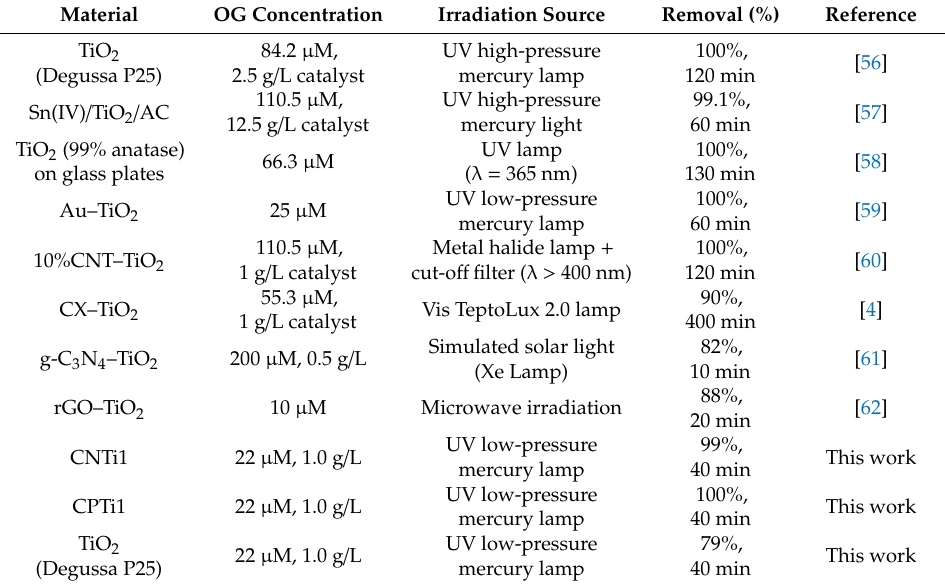
Table 3. Removal of OG obtained by photocatalysis using di ff erent TiO 2 -based materials.